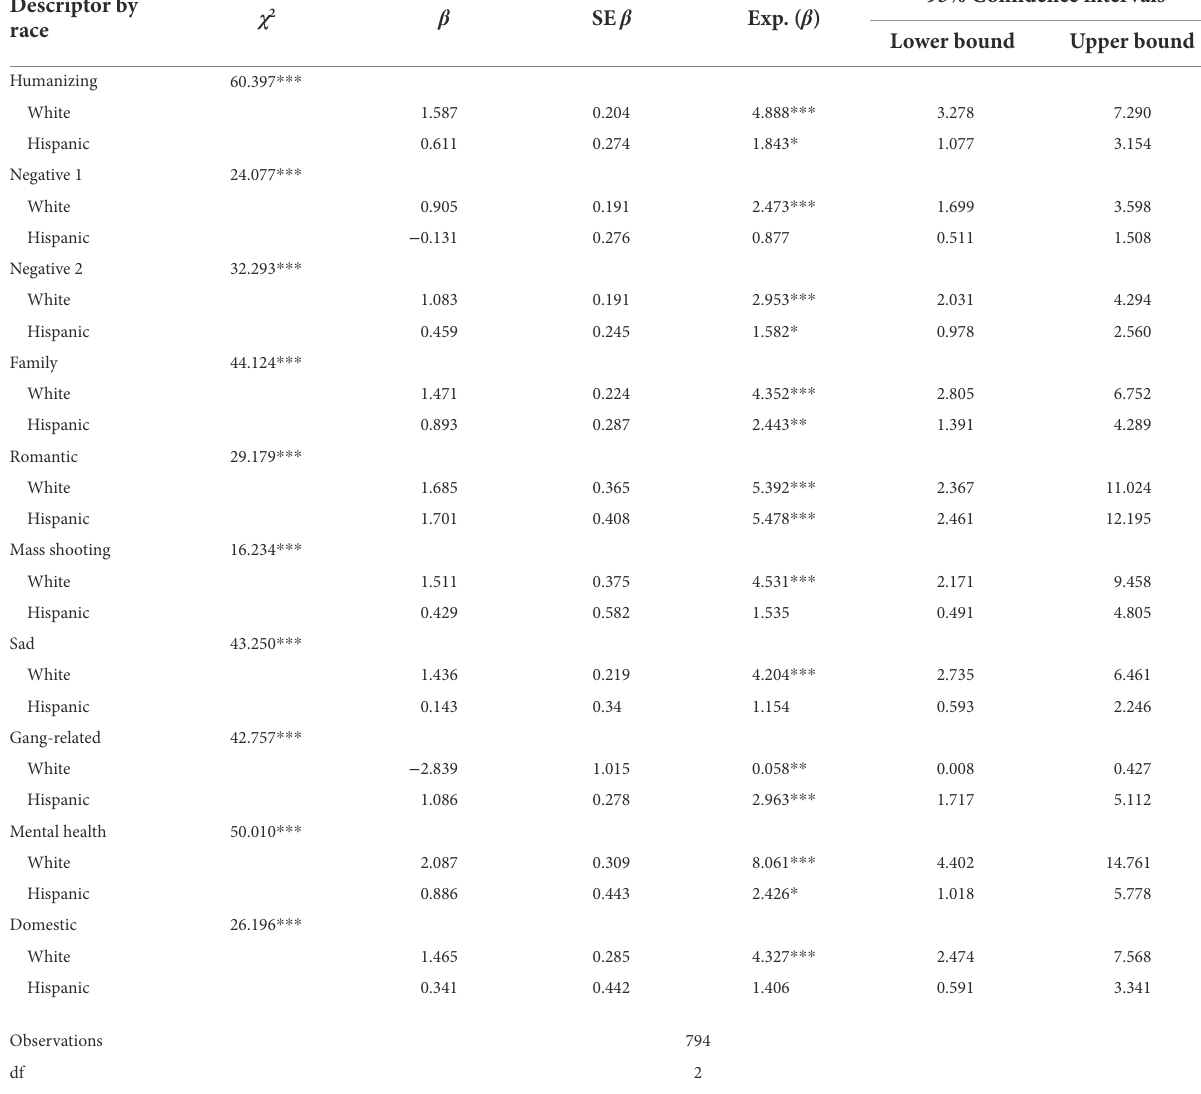
TABLE 8 Model 1: binary logistic regression analysis of descriptor type usage in media coverage of mass shooters by race. Descriptor by